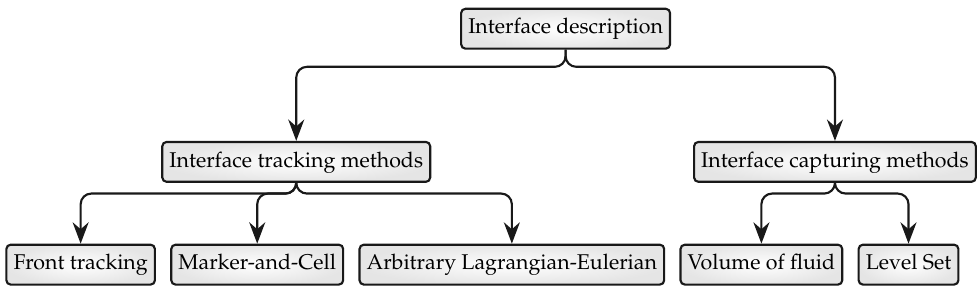
Figure 1. An overview of the numerical approaches and their branches that have been introduced and implemented for the description of the dispersed phase topology or for the localization of the interface between two